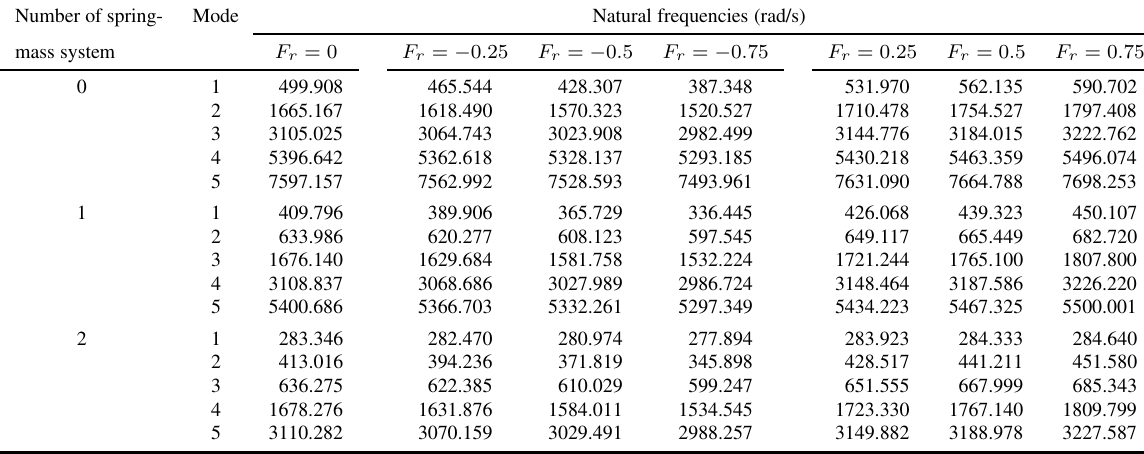
Table 3 The lowest five natural frequencies of the single-span beam used in examle 3